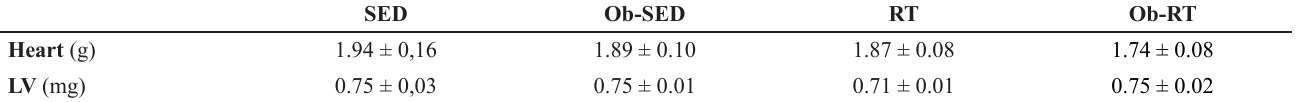
Table 2 - Rat Heart weight and LV mass of Sedentary (SED), Obese sedentary (Ob-SED), resistance training (RT), and obese trained groups.